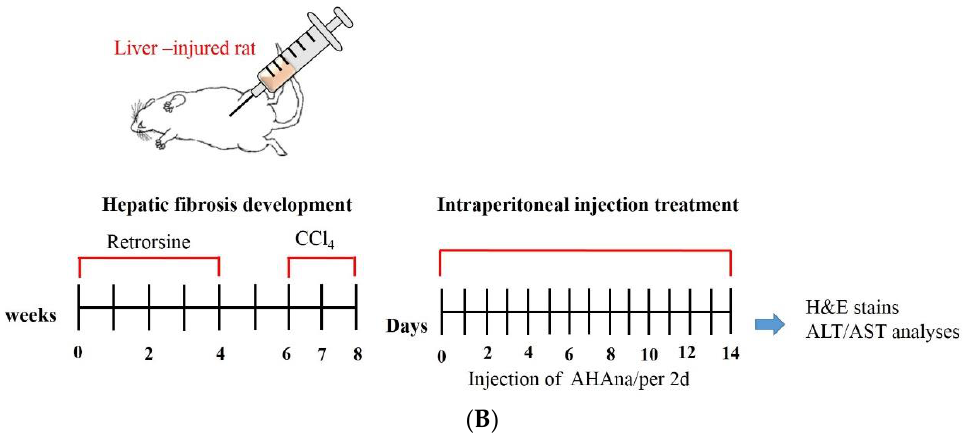
Figure 1. The schematic diagrams representing the preparation processes of AHAna aggregates ( A ) and the procedures and timescale for developing the rat liver injured mode ( B ).